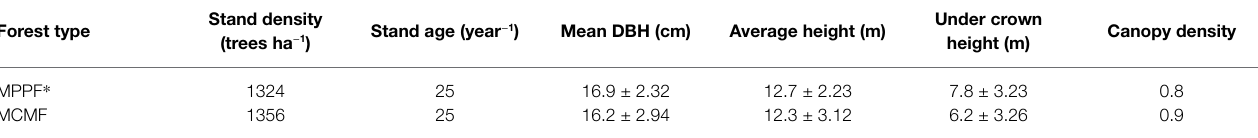
TABLE 1 | Characteristics of the two selected forest types in the study site (DBH = Diameter at breast height). Forest type